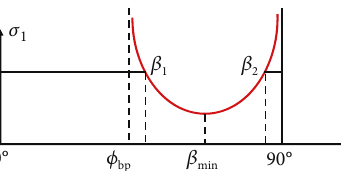
Figure 3: Jaeger ’ plane of weakness model failure envelops [24].